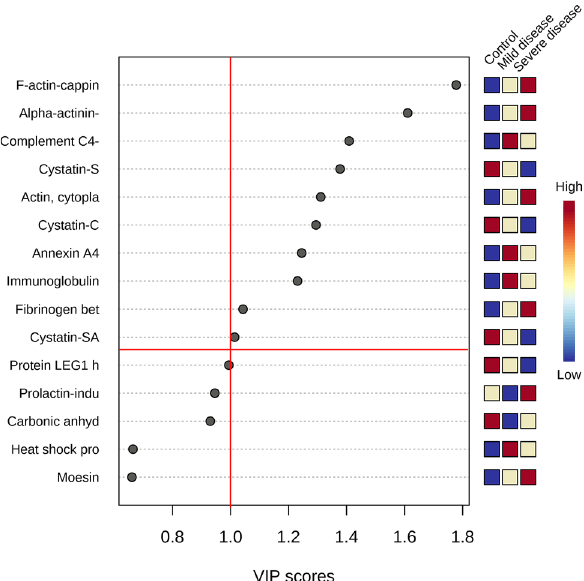
Figure 9. Variable Importance in Projection (VIP) represents the contribution score of the proteins that mostly contribute to the differentiation within the different COVID-19 severities and the control group. The red and blue boxes on the right indicate the relative amounts of the corresponding protein in each group under study. Horizontal and vertical red lines are delimiting the proteins with VIP value above 1. Source: Metaboanalyst 5.0 (https:// www. metab oanal yst. ca).